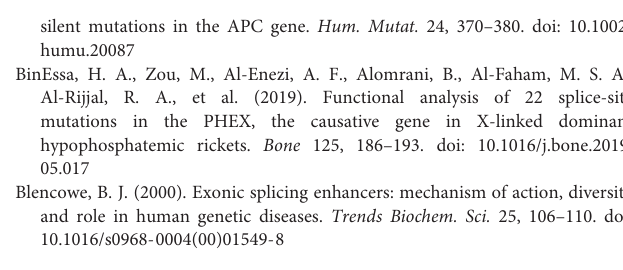
Supplementary Figure 1 | CYP27B1 mini-gene sequence (NM_000785). The c.590G > A mutation is highlighted in Bold. Supplementary Figure 2 | A previously reported homozygous duplication mutation in patient 1 from family